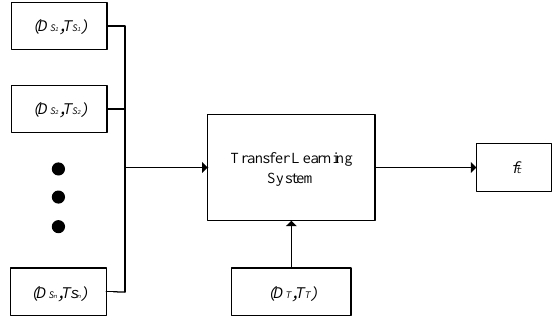
Figure 1. Framework of Multi-source Transfer Learning.